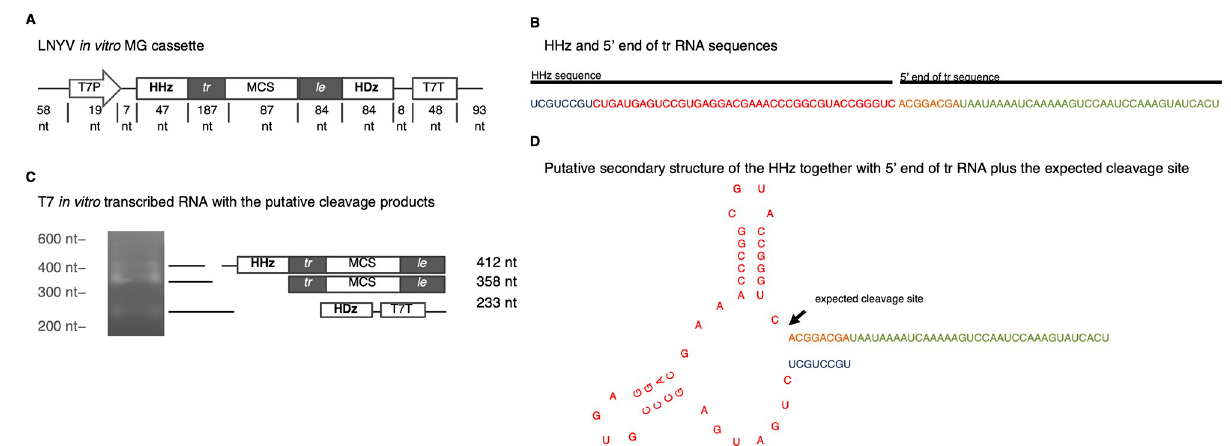
Fig 2. Testing ribozyme auto-cleavage in the LNYV minigenome cassette. ( A ) Diagram of construct used in T7 in vitro RNA transcription showing the LNYV minigenome cassette tr – MSC—le flanked by hammerhead and hepatitis delta ribozymes for generating exact viral termini by auto-cleavage. The minigenome cassette is flanked by the T7 promoter and terminator for in vitro transcription. ( B ) RNA sequence of HHz and the 5’ end of tr used in the minigenome cassette. The first 8 nucleotides of HHz were changed to allow base-pairing with the first 8 nucleotides of the tr sequence. ( C ) Agarose gel showing putative bands of tr – MCS—le fragment (358 nt), HHz—tr–MCS—le (412 nt), and HDz—T7T (233 nt). ( D ) The expected secondary structure of the HHz with its first 8 nucleotides complimenting those of the tr sequence plus the putative cleavage site